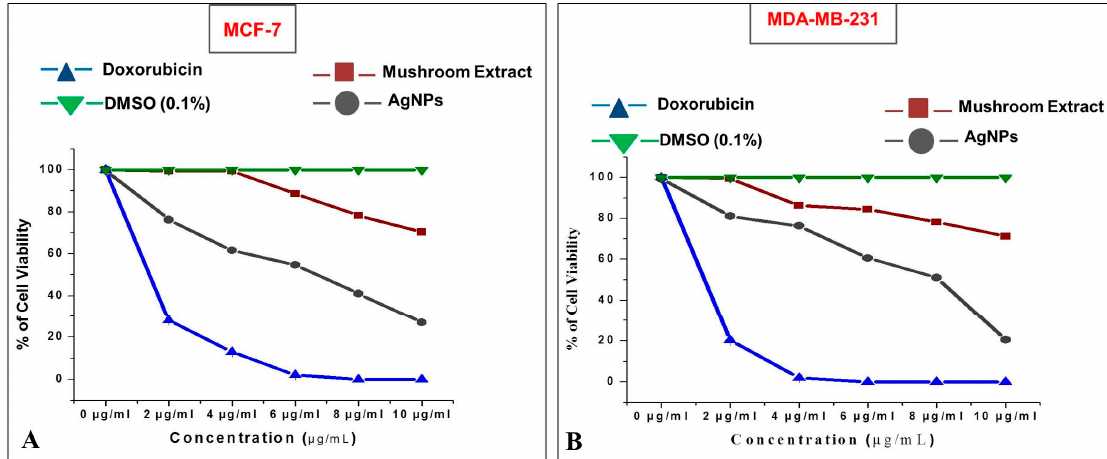
Figure 10. Cytotoxic effect of silver nanoparticles (AgNPs) on: ( A ) MCF-7; ( B ) MDA-MB-231 human breast cancer cells.